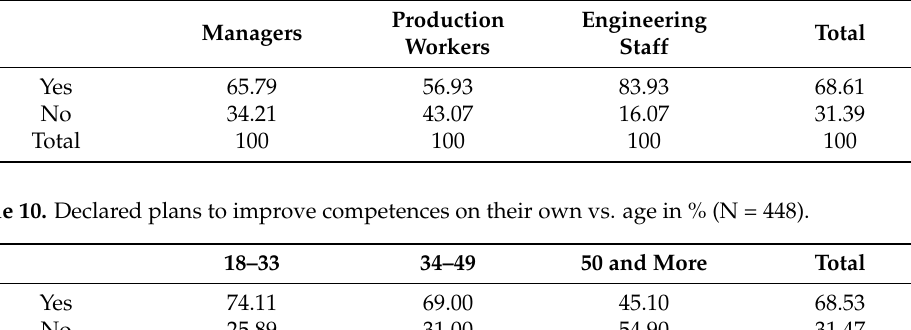
Table 9. Declared plans to improve competencies in-house vs. position in % (N = 446).